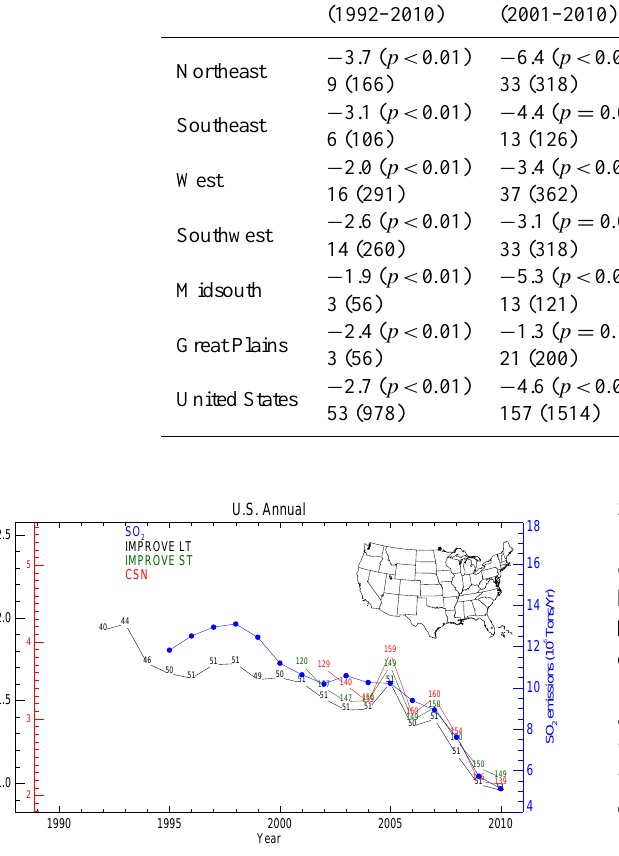
Fig. 6. United States annual mean particulate sulfate ion concentra- tions (µg m − 3 ) from long-term (LT) and short-term (ST) IMPROVE sites (left black axis) and CSN sites (left red axis), and power plant SO 2 emissions (million t yr − 1 ) (right blue axis). The number of complete sites with valid data available for a given year is used as the plot symbol for each time